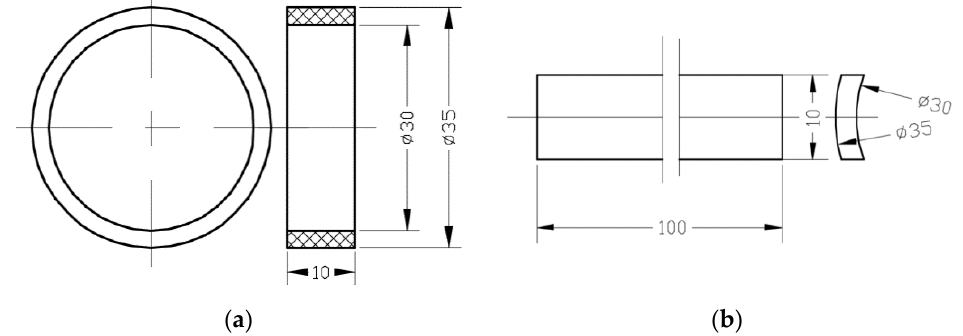
Figure 2. Schematic of the specimen for ( a ) circular tensile strength test and ( b ) axial tensile strength test.